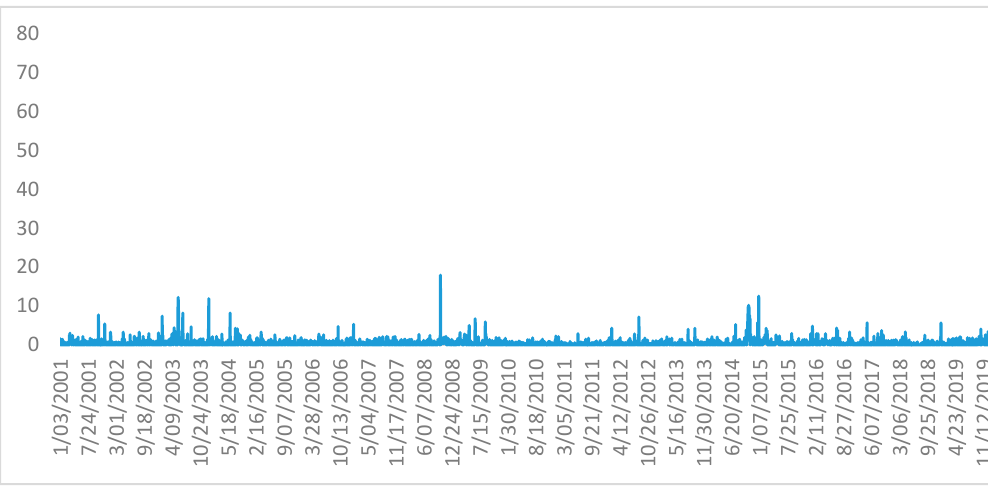
Figure 1. Data plots.